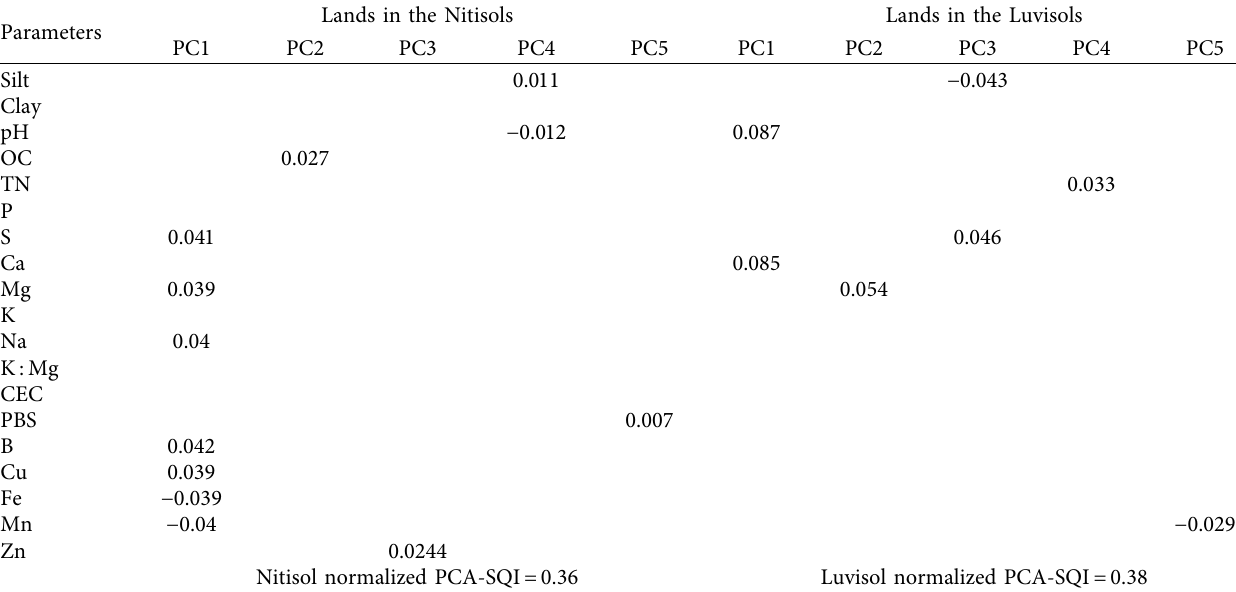
Table 8: Soil quality index (SQI) values of lands in the Nitisols and Luvisols based on a statistical model of normalized PCA. Lands in the Nitisols Parameters